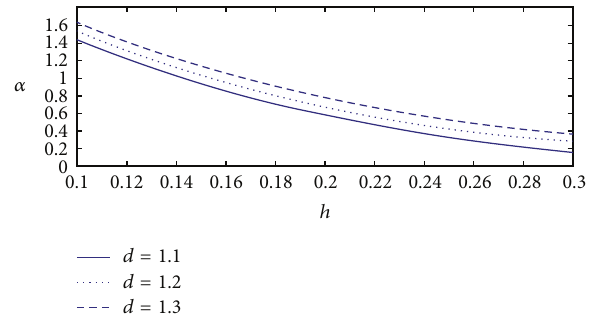
Figure 1: The upper bound ℎ for different 𝛼 .